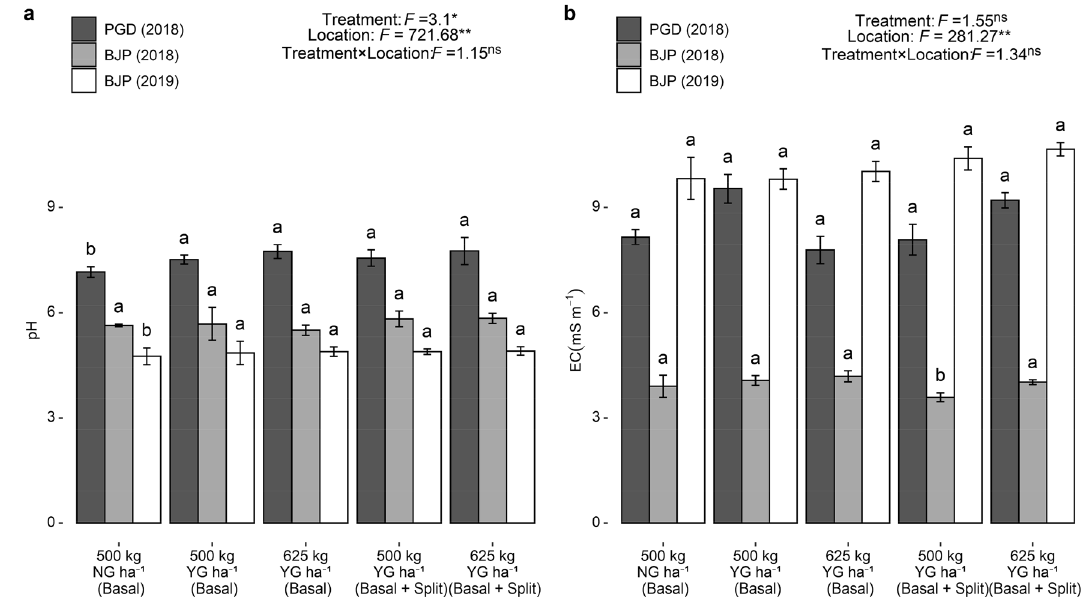
Figure 3. Effect of YG and NG on pH ( a ) and electrical conductivity (EC) ( b ) of post-harvest soils of PGD (2018) and BJP (2018 and 2019). F value and significance level (** P < 0.01, * P < 0.05 and ns P ≥ 0.05). Values followed by a different letter within the same location are significantly different at P < 0.05 probability level. Capped bars at the surface of vertical bars represent the standard deviation, n = 3. YG yellow gypsum, NG natural gypsum, PGD Pavagada, BJP Baljigapade.